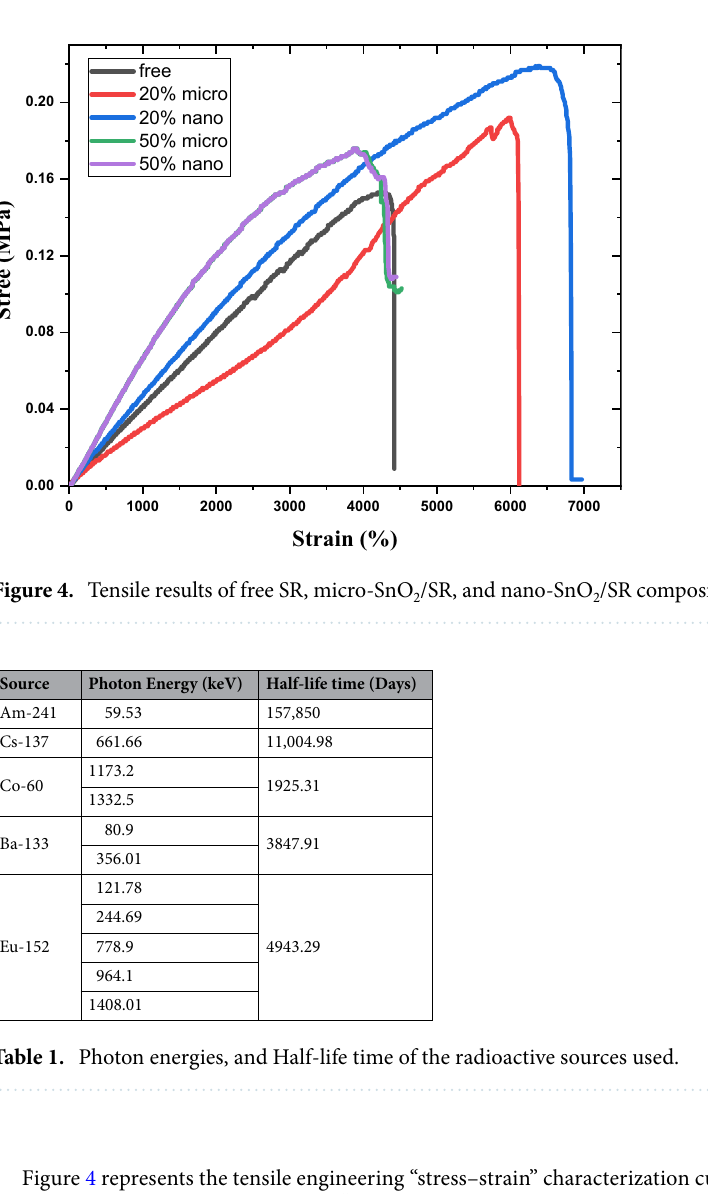
Figure 4 represents the tensile engineering “stress–strain” characterization curve of free silicon rubber, 20% “nano and micro” SnO 2 /SR, and 50% “nano and micro” SnO 2 /SR composites. The stretching and elongation processes of silicon rubber composites lead to cut-out kinks and high elongation distance “strain” is provided by